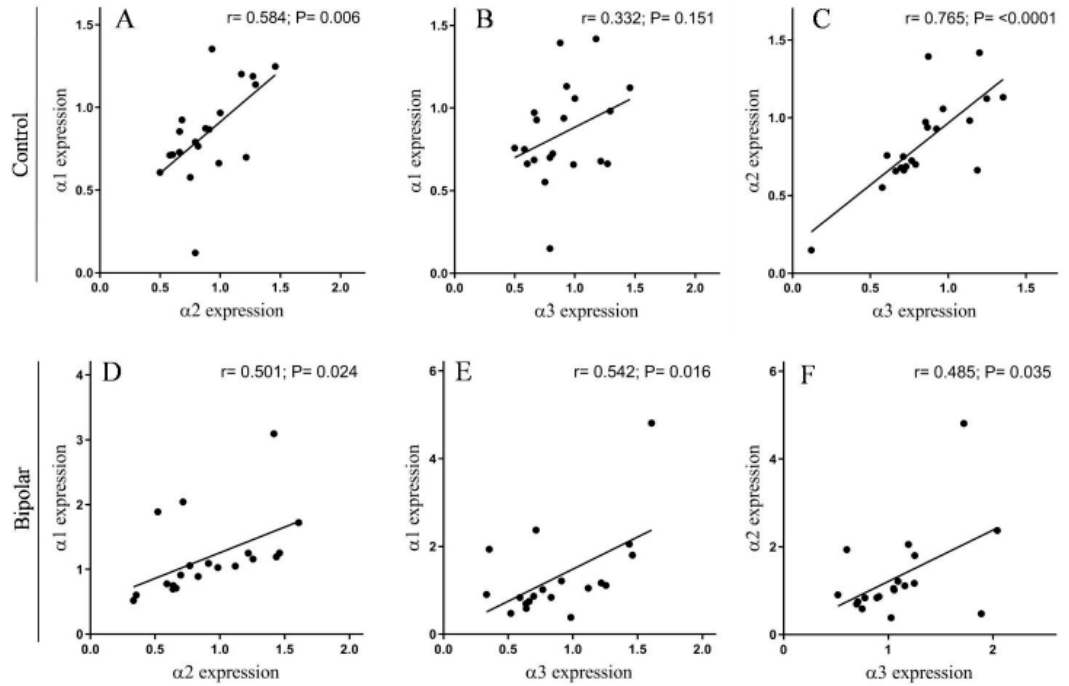
Figure 2. The correlation between the expression of the Na + , K + -ATPase α isoforms in the PFC of controls and BD patients. The different isoform expression levels (Figure 1) in the controls ( A – C ) and BD patients ( D – F ) were correlated. The Pearson correlation coefficient ( r ) and the p value (two tailed) were calculated by using correlation analysis (GraphPad Prism v 8.3.1).